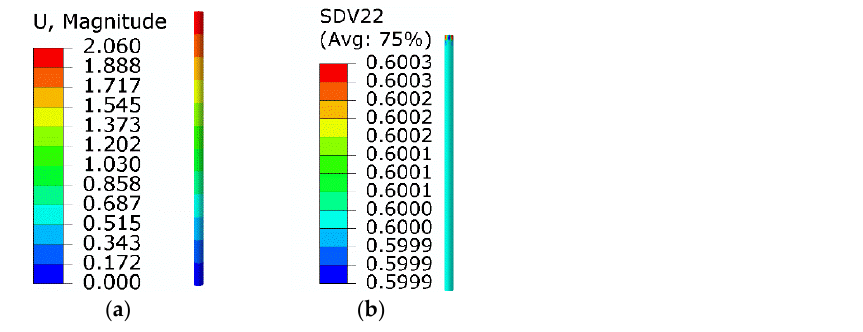
Figure 4. Results of step 1: ( a ) axial displacement; ( b ) the volume fraction of M t .